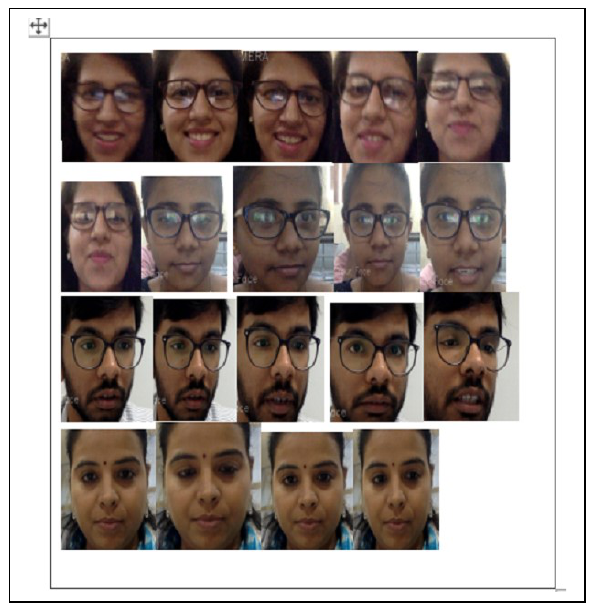
Fig. 4(a) : Input Data (Training data -Sample Images)